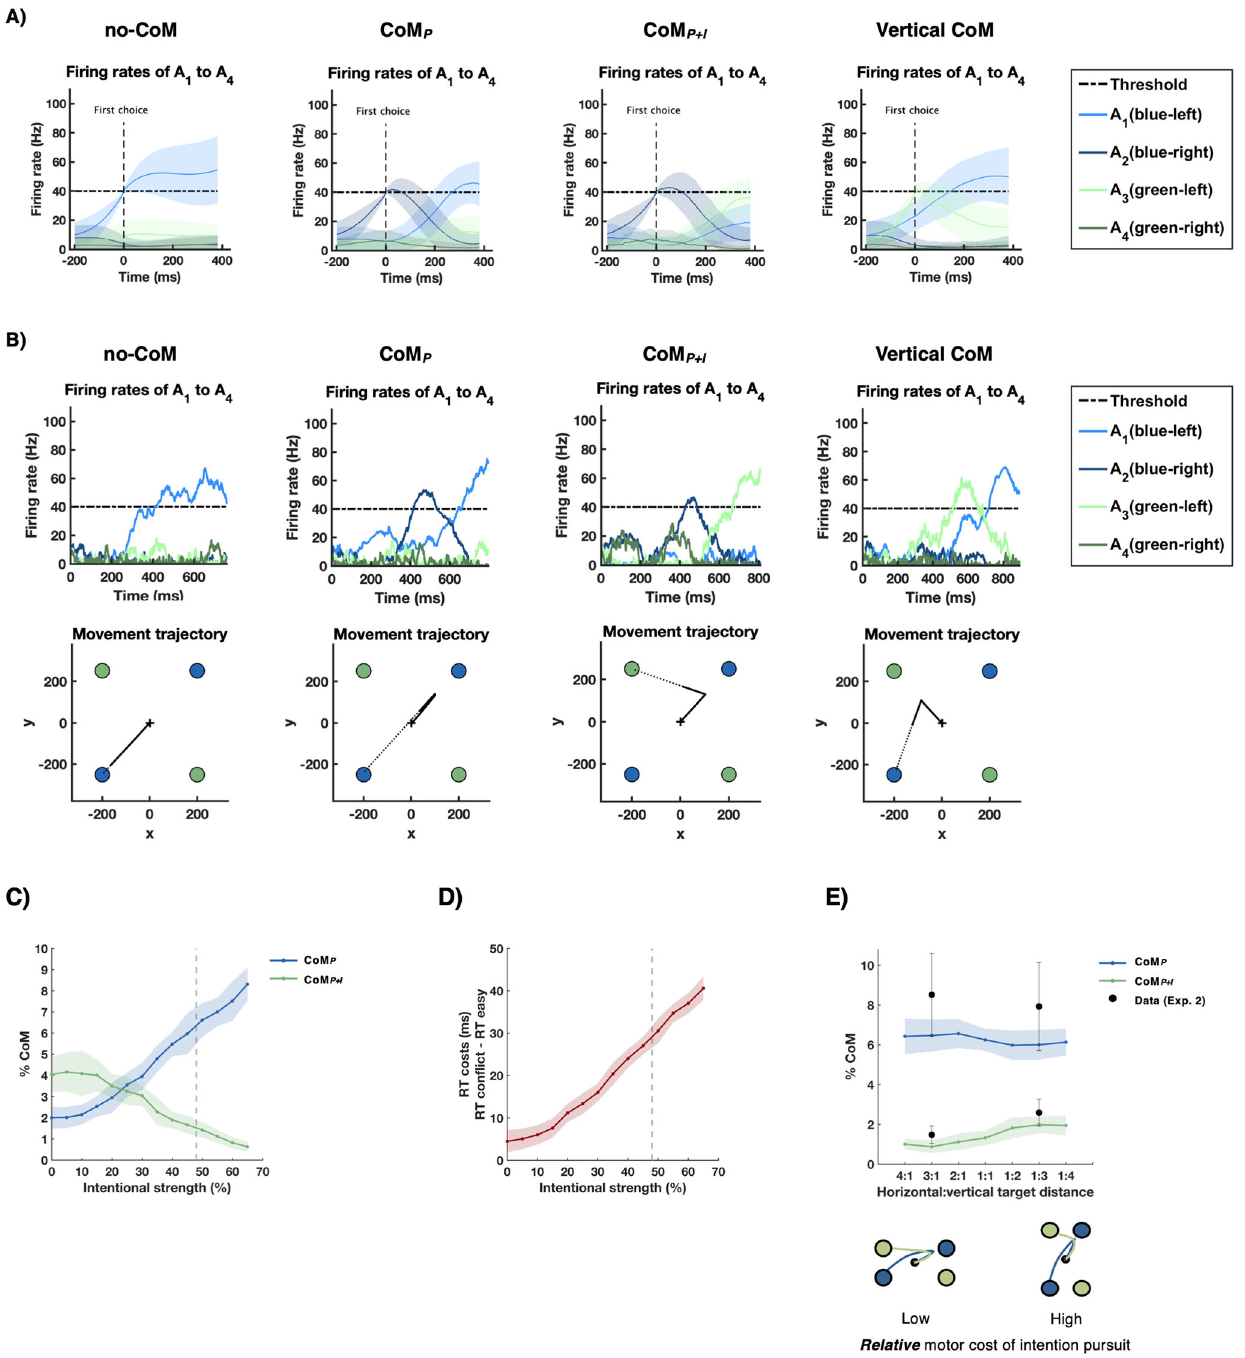
Fig. 6 Changes of Mind (CoM) in attractor network model. A Average fi ring rates of action nodes A 1 to A 4 (M ± 1 SD; n = 30,000 simulated trials) in trials without CoM (no-CoM), perceptual CoM (CoM P ), perceptual + intentional CoM (CoM P + I ), and vertical CoM. Firing rates were locked to time of fi rst threshold crossing ( fi rst choice). For illustration purposes, only trials where the fi nal choice was left-blue were included, except for CoM P + I where a change with respect to the colour intention resulted in a fi nal left-green choice. B Single-trial simulations showing fi ring rates of action nodes (upper row) and the resulting movement trajectories (bottom row) for no-CoM, CoM P , CoM P + I and vertical CoM. Dotted trajectories indicate completion of movements after the non-decision time of 380 ms (i.e., after the time period during which CoM can occur). C Effect of intentional strength on CoM P (blue) and CoM P + I (green). Stronger intentions result in lower frequency of intention reversals. D Stronger intentions increase RT costs in con fl ict trials (relative to RTs in easy trials). E Effect of target distance on CoM P (blue) and CoM P + I (green). Higher motor cost of intention pursuit increases frequency of intention reversals. Grey dashed lines in C and D indicate strength of intention in the model that was optimised to the results obtained in Exp. 1. In C – E , data are presented as the mean ± 1 SD from n = 30 model simulations with 1000 trials each. Black data points in E represent behavioural results from Exp. 2 ( n = 16; M ± 1